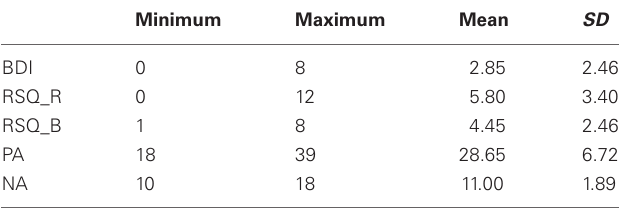
Table 1 | Questionnaire